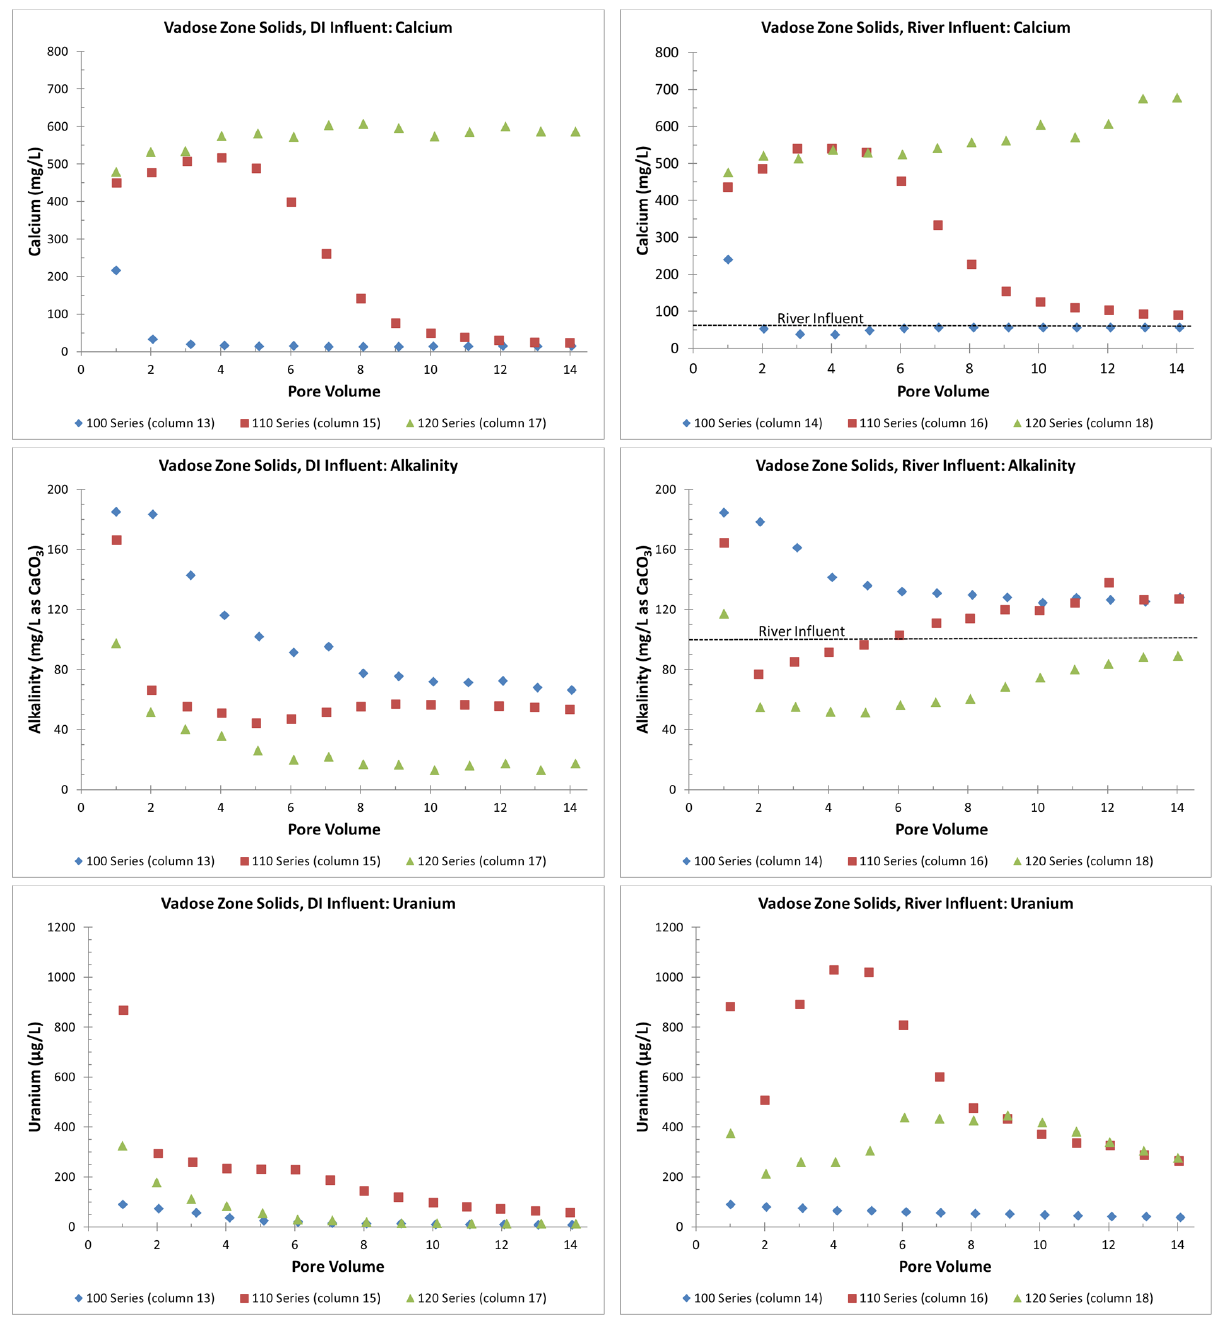
Figure 5. Effluent calcium, alkalinity, and uranium concentrations in VZ columns for PVs 1 through 14. Dashed horizontal lines indicate influent Gunnison River water concentrations for calcium and alkalinity. Uranium in DI and Gunnison River water was 3 µg/L or less.